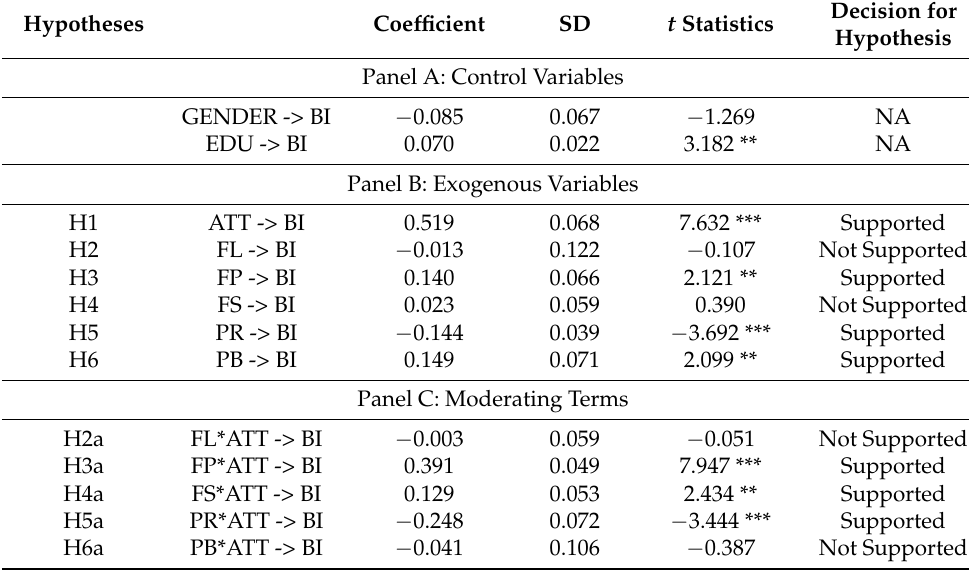
Figure 2. The estimated structural model with path coefficients. Table 5. Path coefficients summary for direct and moderating